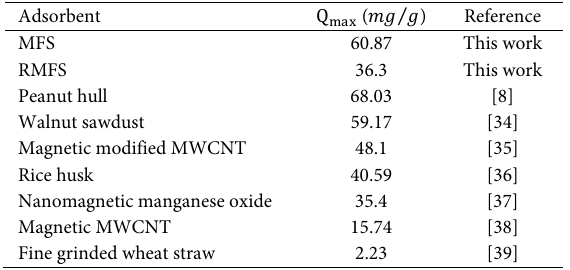
Fine grinded wheat straw